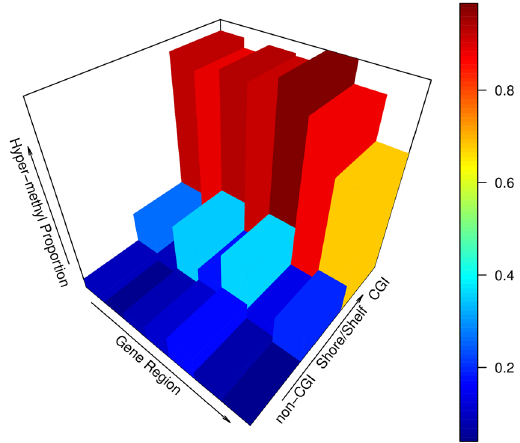
Figure 4. A 3-dimensional histogram showing the proportion of age-methylated CpGs at each combination of gene regions (intergenic region, TSS1500, TSS200, 5 ′ UTR, 1stExon, gene body, 3 ′ UTR) and locations to CpG island (from open sea or non-CGI to shore/shelf and to CGI). It is clearly shown that methylation level at each gene region is mainly driven by age-associated methylation (gain) at